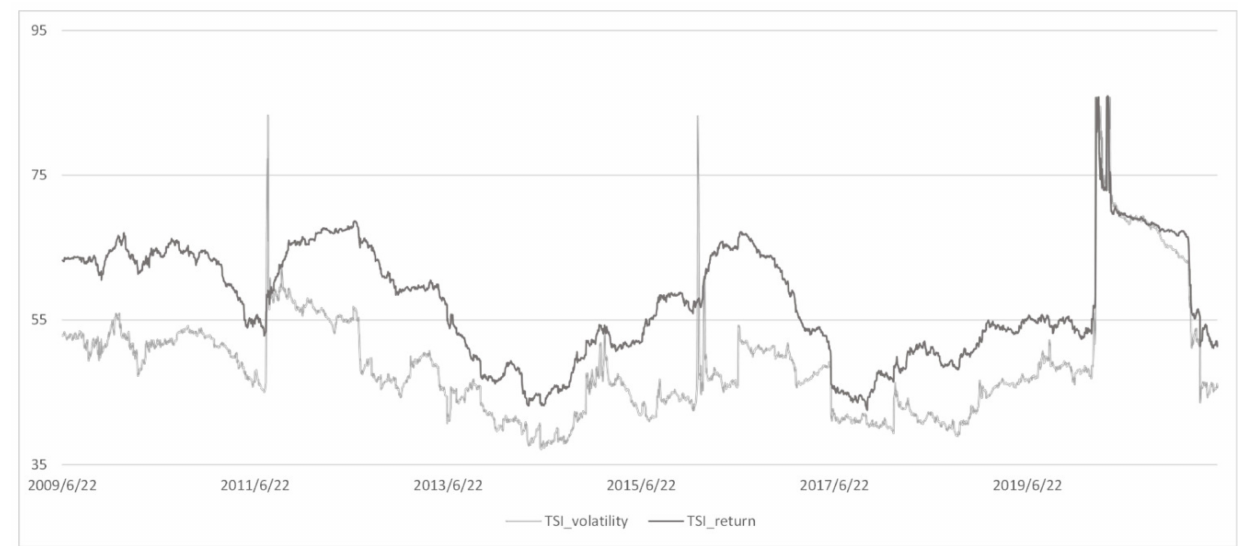
Figure 2. Total connectedness with rolling windows in price return system and price volatility